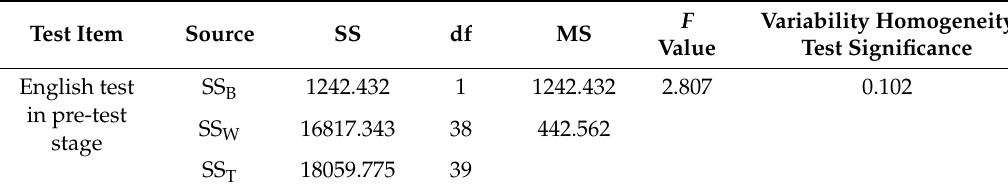
Table 3. Summary of the testing whether the learning ability of both groups was the same and, thus, was comparable. This test was conducted in the pre-test stage of the experiment, in order to test whether the groups were comparable and showed similar learning ability. The results show no significant di ff erence between groups.